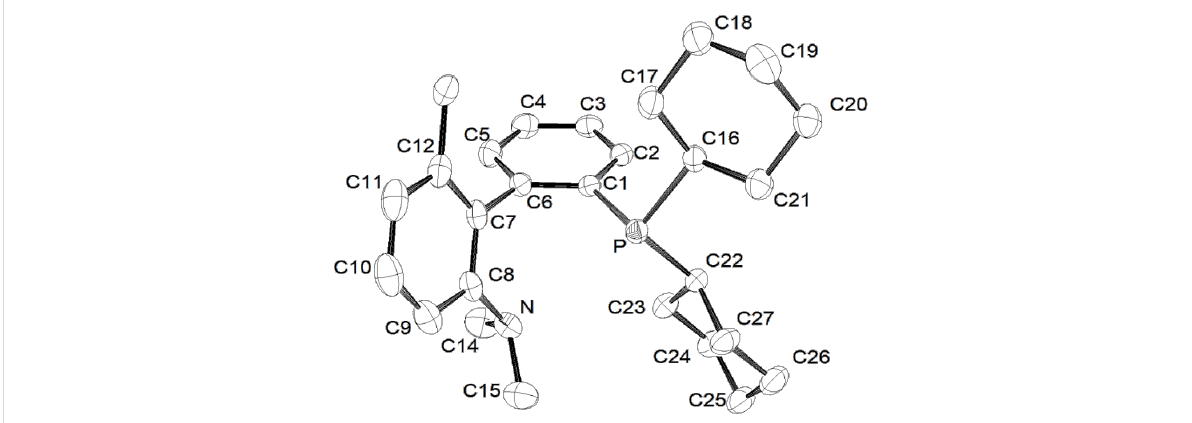
Figure 4: Molecular structure of compound 3a (crystallized from ethyl acetate/hexane) [74].